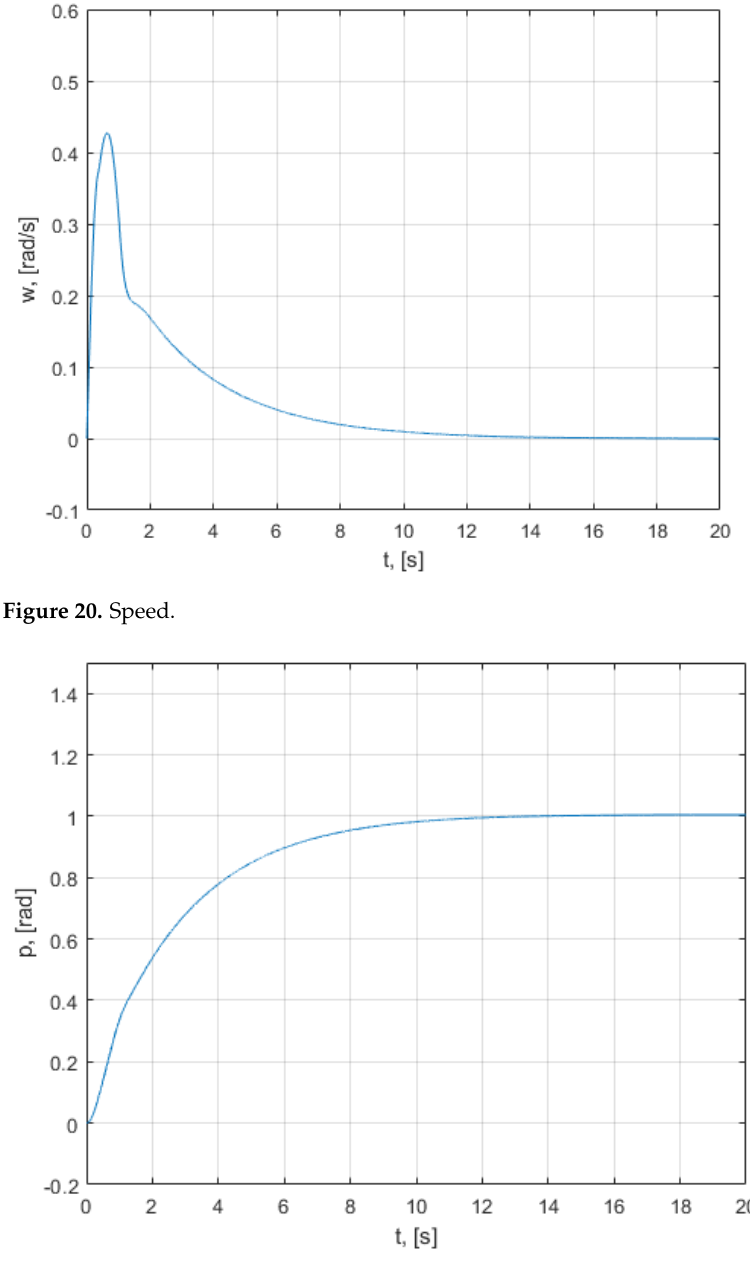
Figure 21. Figure 21. Position.